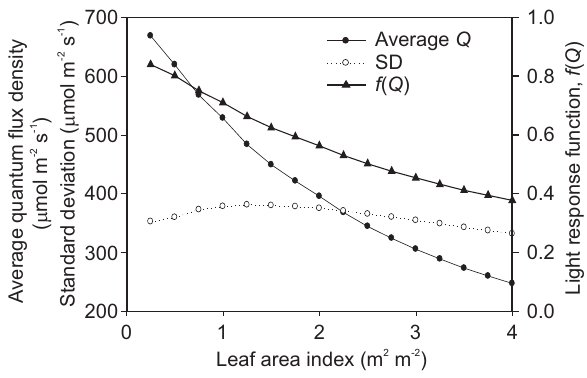
Fig. 10. Mean and standard deviation of the leaf average quantum flux density and corresponding true values of branch light response f (Q) function (Eq. 16) in relation to the amount of leaf area en- closed in the cuvette. f (Q) is taken as 1.0 at the single leaf level. In these simulations, incoming quantum flux density on horizontal surface above the branch was taken as 1000µmolm − 2 s − 1 . Further details of the simulation as in Fig.